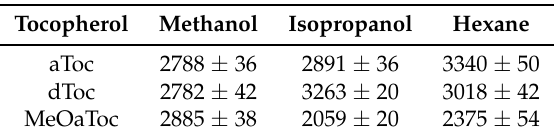
Table 1. Molar extinction coefficients (M − 1 cm − 1 ) at 290